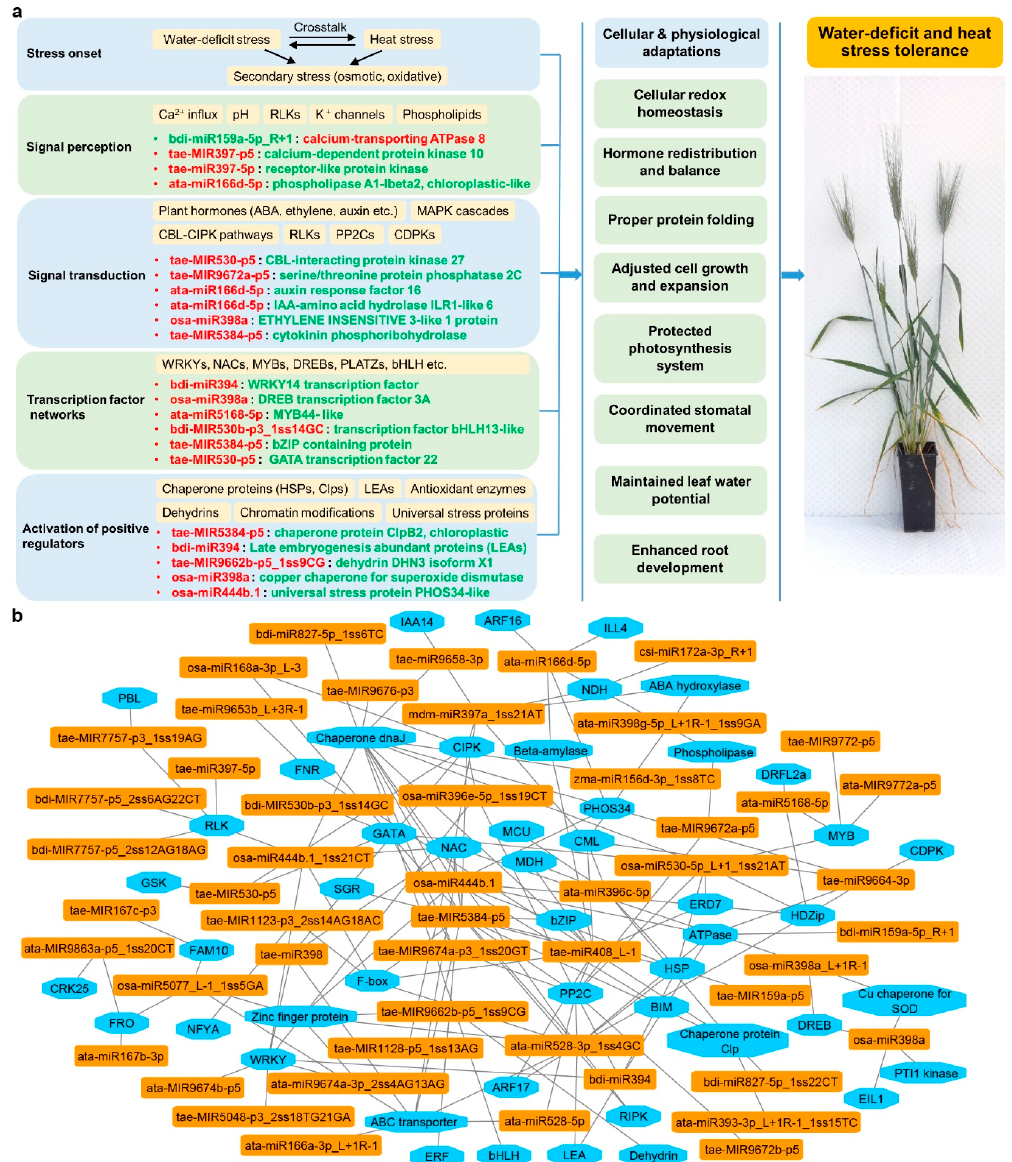
Figure 6. Water-deficit and heat stress response network mediated by key miRNA-RNA modules in durum wheat. ( a ) Examples of key miRNA-mRNA modules involved in the stress response networks. miRNA or gene names highlighted in green represent up-regulation under water-deficit plus heat stress; miRNA or gene names highlighted in red represents up-regulation under water-deficit plus heat stress; ( b ) multiple-to-multiple regulatory connections between miRNAs (orange) and their targets (blue).